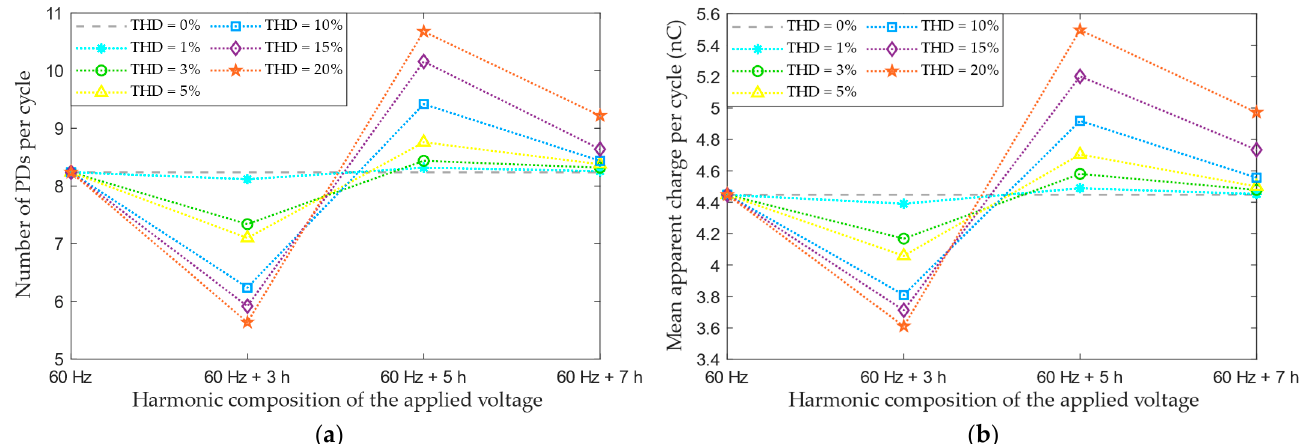
Figure 7. Simulated results for the case wherein a voltage distorted by the 7th harmonic component with 𝜑 (cid:3035) = 0° and THD = 20% was applied: ( a ) electric fields over time; ( b ) PDs’ current pulses.